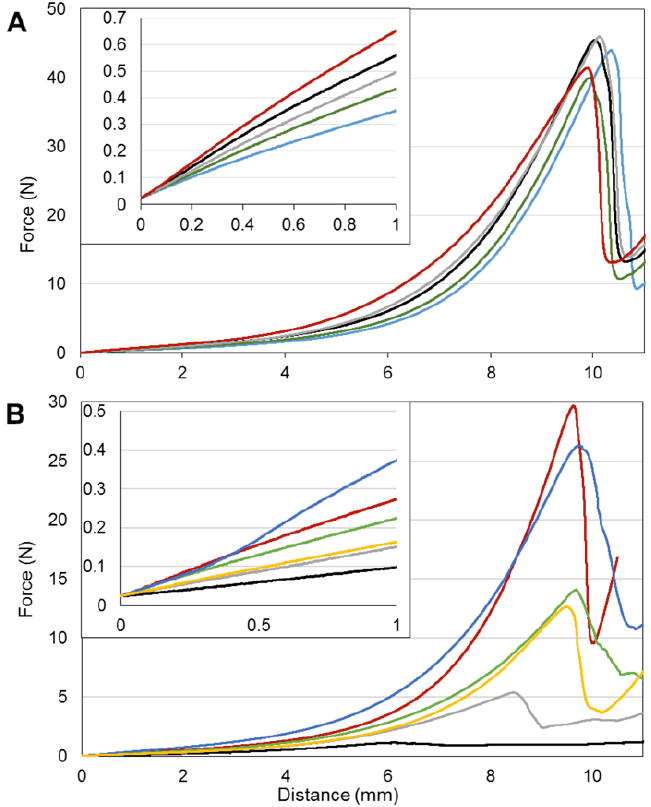
Figure C1. Stress-deformation curves of gel cylinders presented in Figures 1B and 2B ( A ) and Figure 3 ( B ). The inserted picture shows the initial compression where the gels display elastic behaviour. Young’s modulus is calculated from 0.1 to 0.3 mm. (A) 1% ( w / v ) M. pyr . ( ), 1% ( w / v ) M. pyr . +